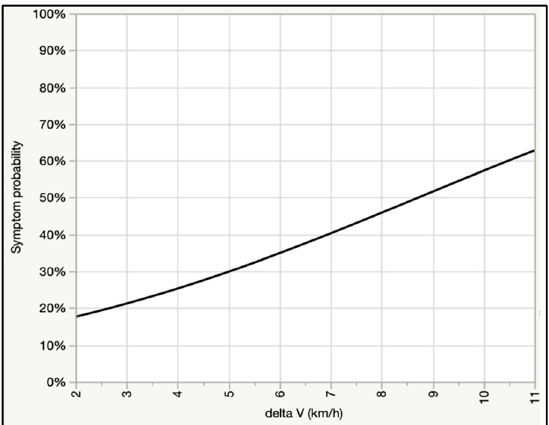
Figure 3. Risk of post-test symptoms for 381 crash tests.